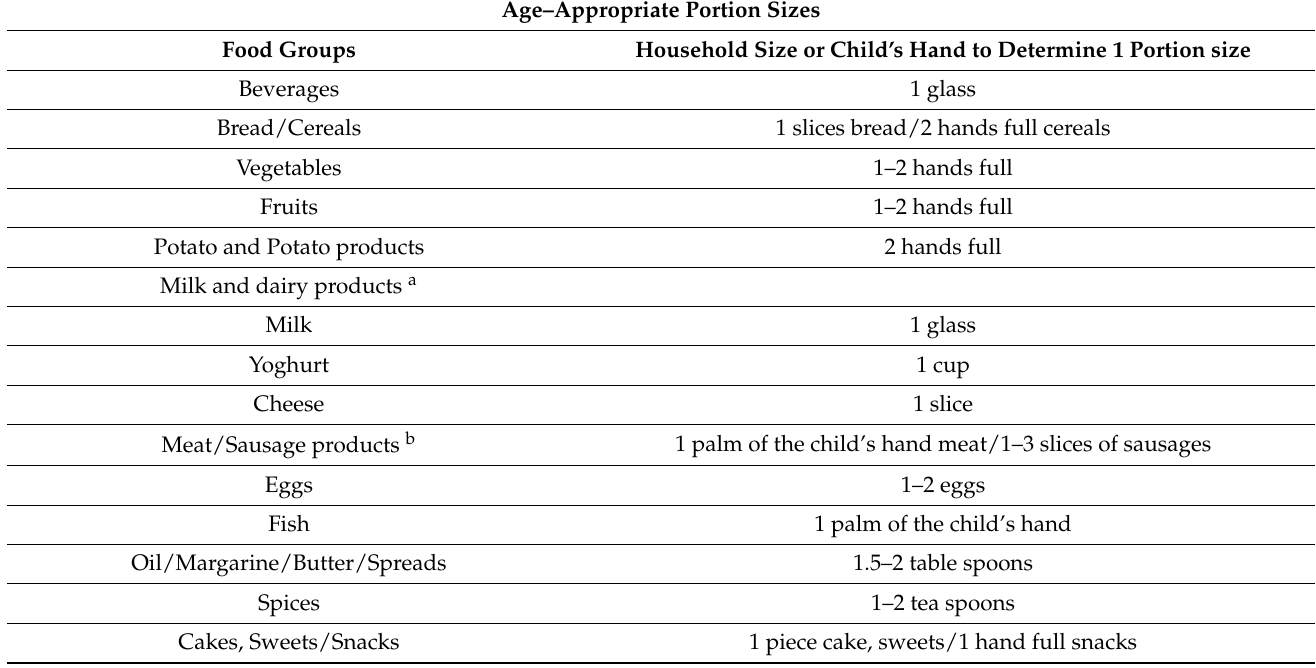
Table 2. Age-appropriate portion sizes used for the yellow-marked area in the FCS traffic light table. Age–Appropriate Portion